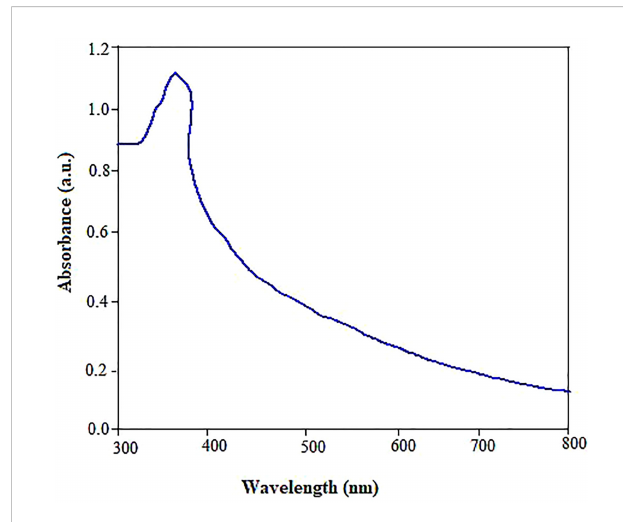
FIGURE 1 UV-Vis absorbance spectra of ZnO NPs synthesized using pecan leaf